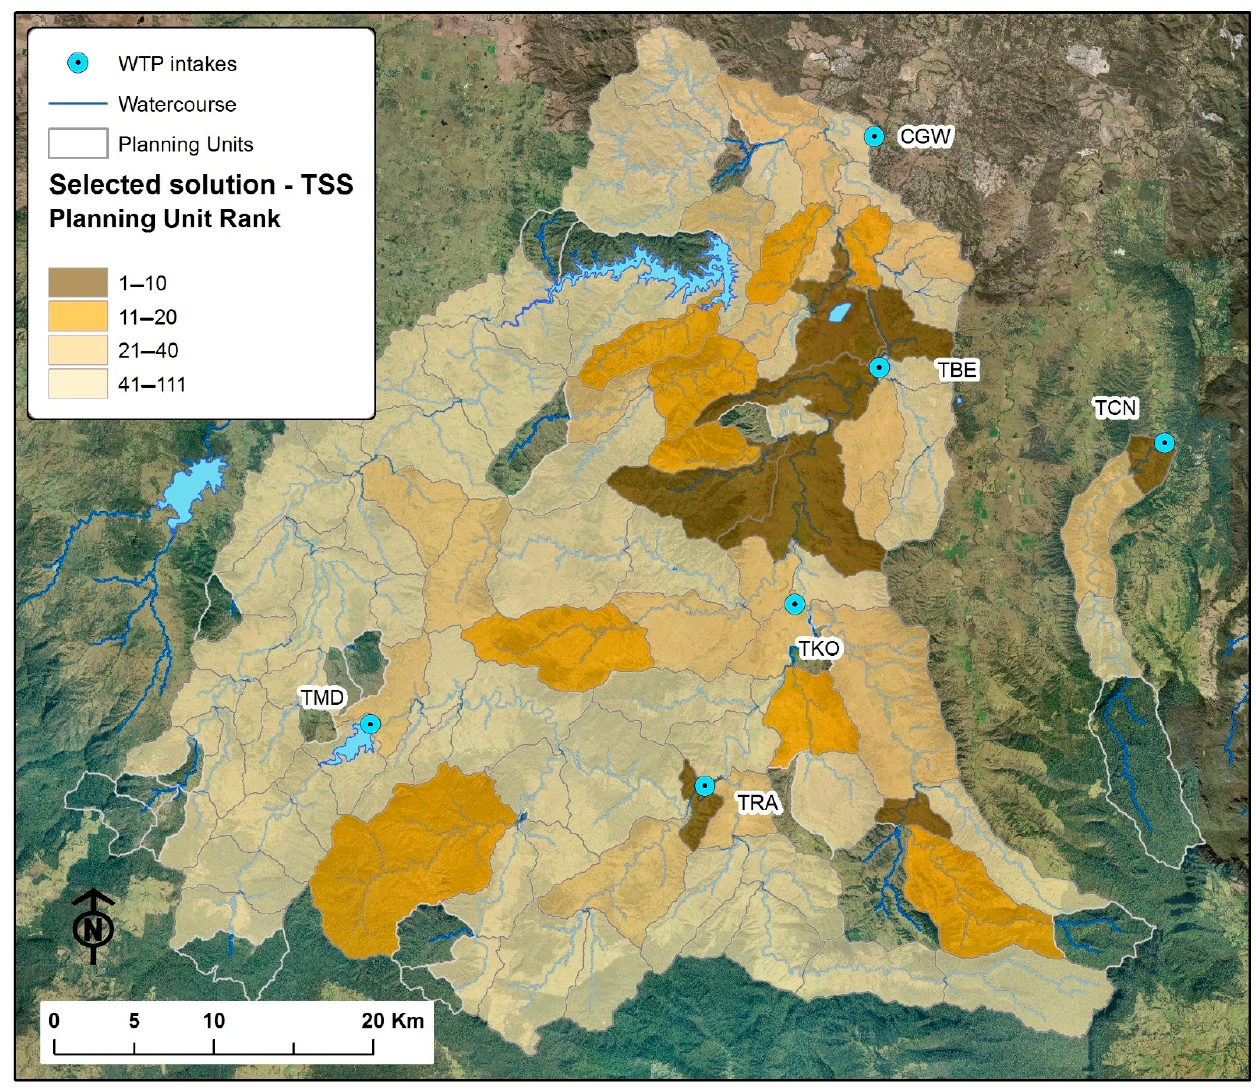
Figure 7. Prioritised Planning Units based on net TSS reduction at CGW. Planning Units without a rank (no colour shading) have no interventions applied in the scenario solution.